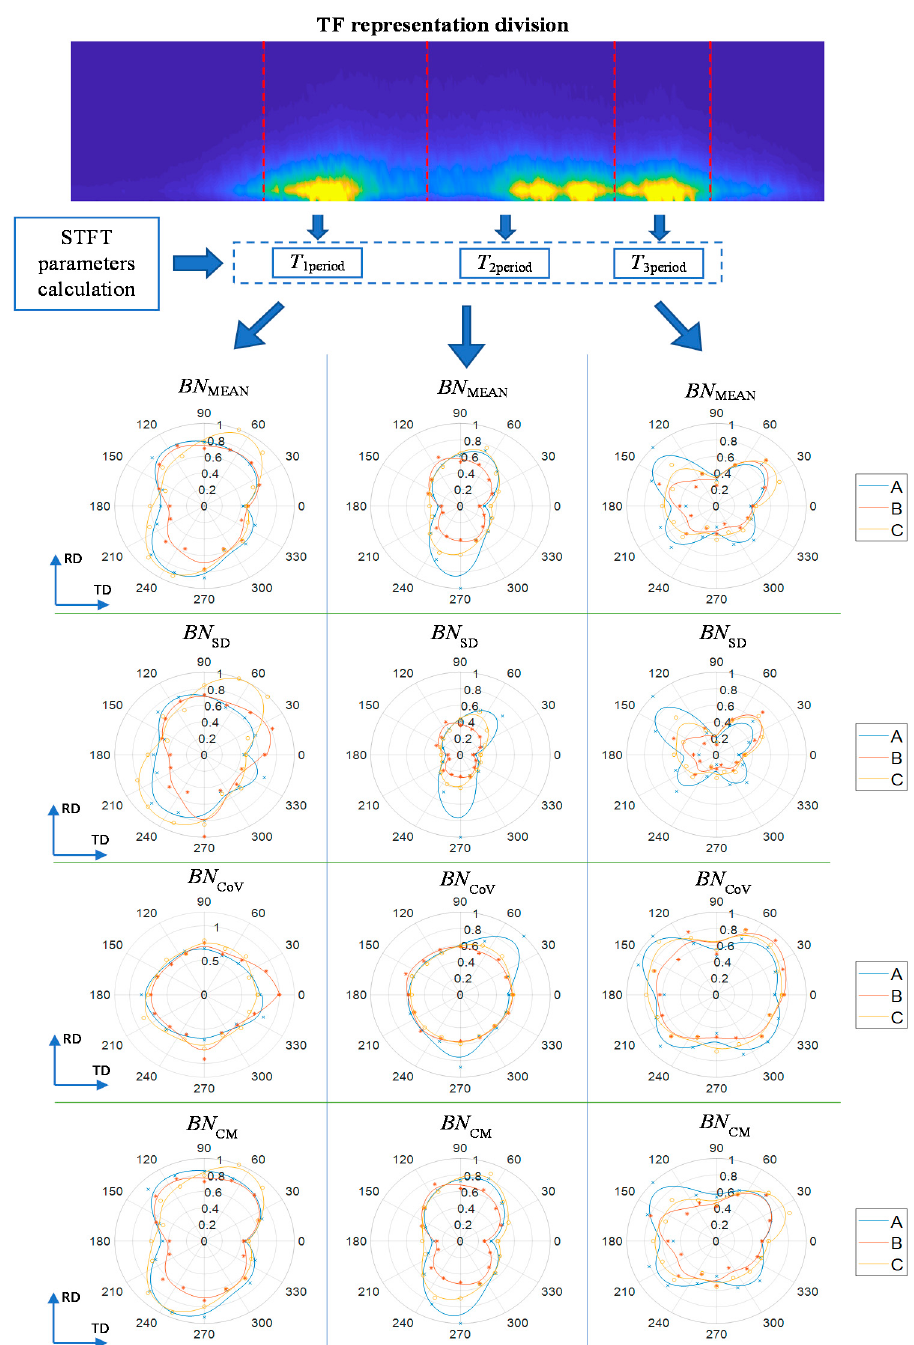
Figure 10. Selected time-frequency ( TF ) features angular distributions in three MBN activity subbands obtained for three locations (A, B and C) at the examined sample.